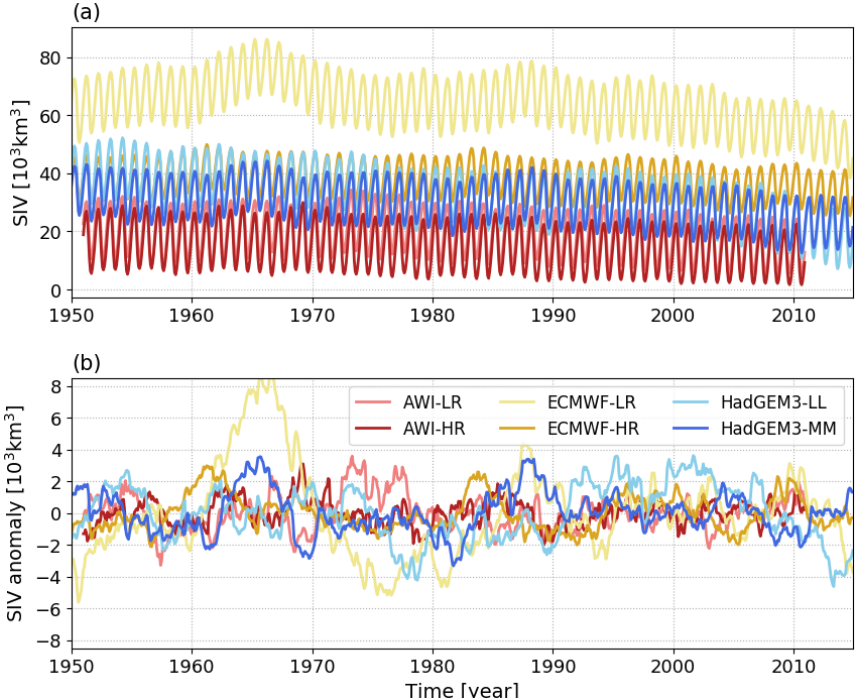
Figure 1. Sea ice volume time series from the six model configurations used in this work: (a) absolute values and (b) anomalies in which the long-term trends and the seasonal cycles were subtracted from the original time series.